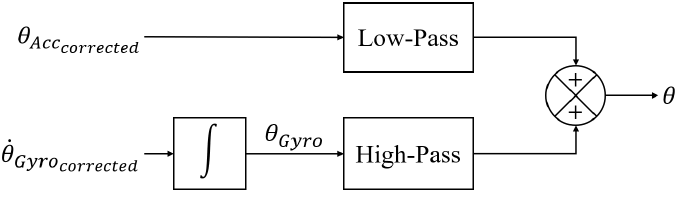
Figure 5. Flowchart of complementary filter.